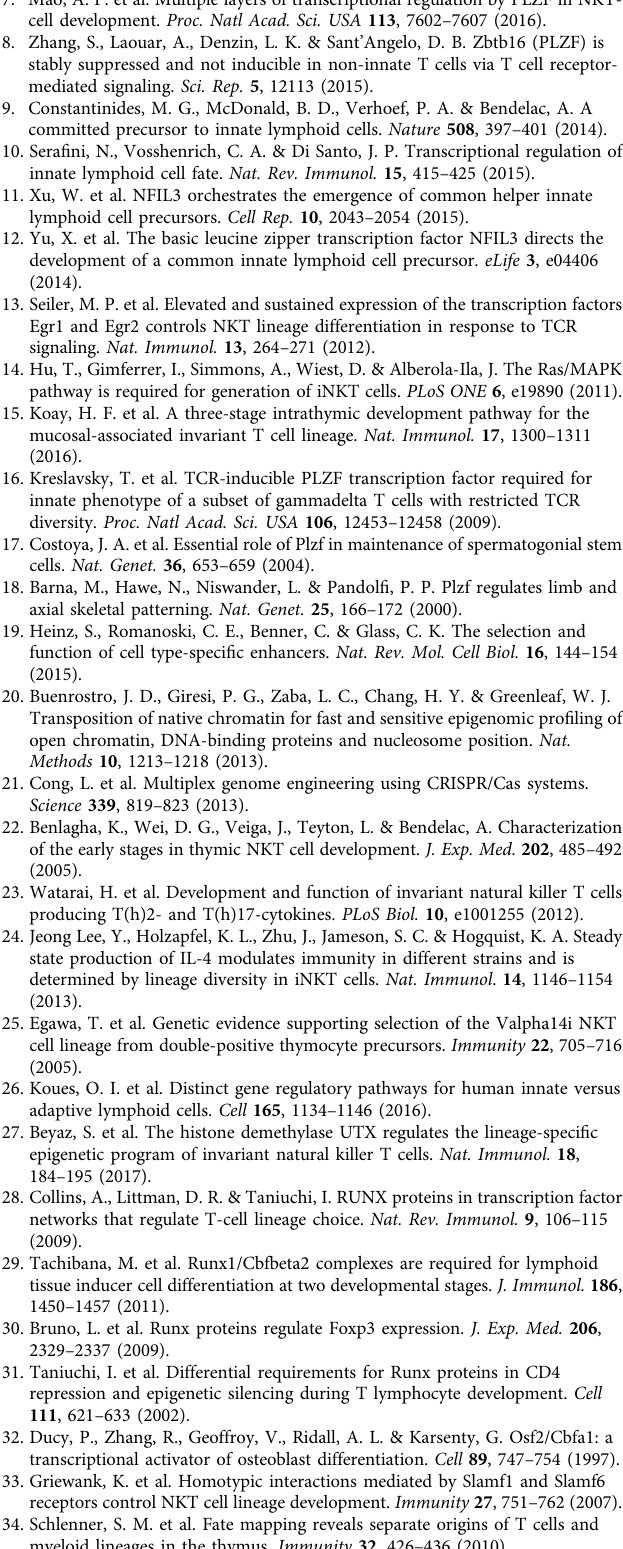
(Supplementary Table 1) was annealed and ligated to linearized pT7-gRNA vector. Linearized pT3TS-nCas9n was puri fi ed and used as the template for in vitro transcription (IVT) using mMESSAGE mMACHINE T3 Transcription Kit (AM1348; ThermoFisher Scienti fi c). The ligated sgRNA constructs were linearized, puri fi ed and then used as the template for IVT using MEGAshortscript T7 Transcription Kit (AM1354; ThermoFisher Scienti fi c). Both the Cas9 mRNA and the sgRNAs were puri fi ed using MEGAclear kit (AM1908; ThermoFisher Scien- ti fi c) and eluted in RNase-free water. C57BL/6J females at 9 – 15 weeks of age were screened for non-estrus state and were superovulated with 5-5.5 IU PMSG (Millipore). 46.5h later mice were given 5-5.5 IU HCG (Sigma) and mated 1.5 h later to C57BL/6J males. The next morning the females were checked for the presence of a vaginal plug, and those having one were harvested for fertilized eggs. Injection of the CRISPR reagents into the pronucleus was performed by using an Eppendorf FemptoJet. Surviving eggs were transplanted in CD-1 pseudopregnant females. The founders were screened with PCR followed by sequencing. The sgRNAs and corresponding deletions obtained are listed in Supplementary Table